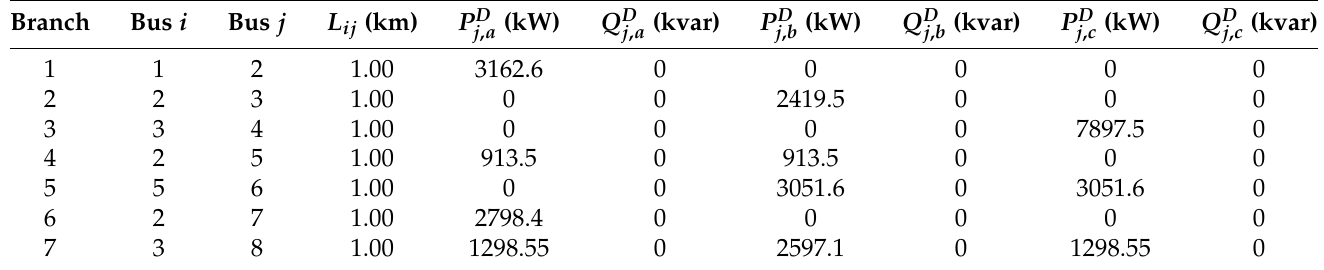
Table 8. Parametric information of the 8-bus test feeder for the unbalanced